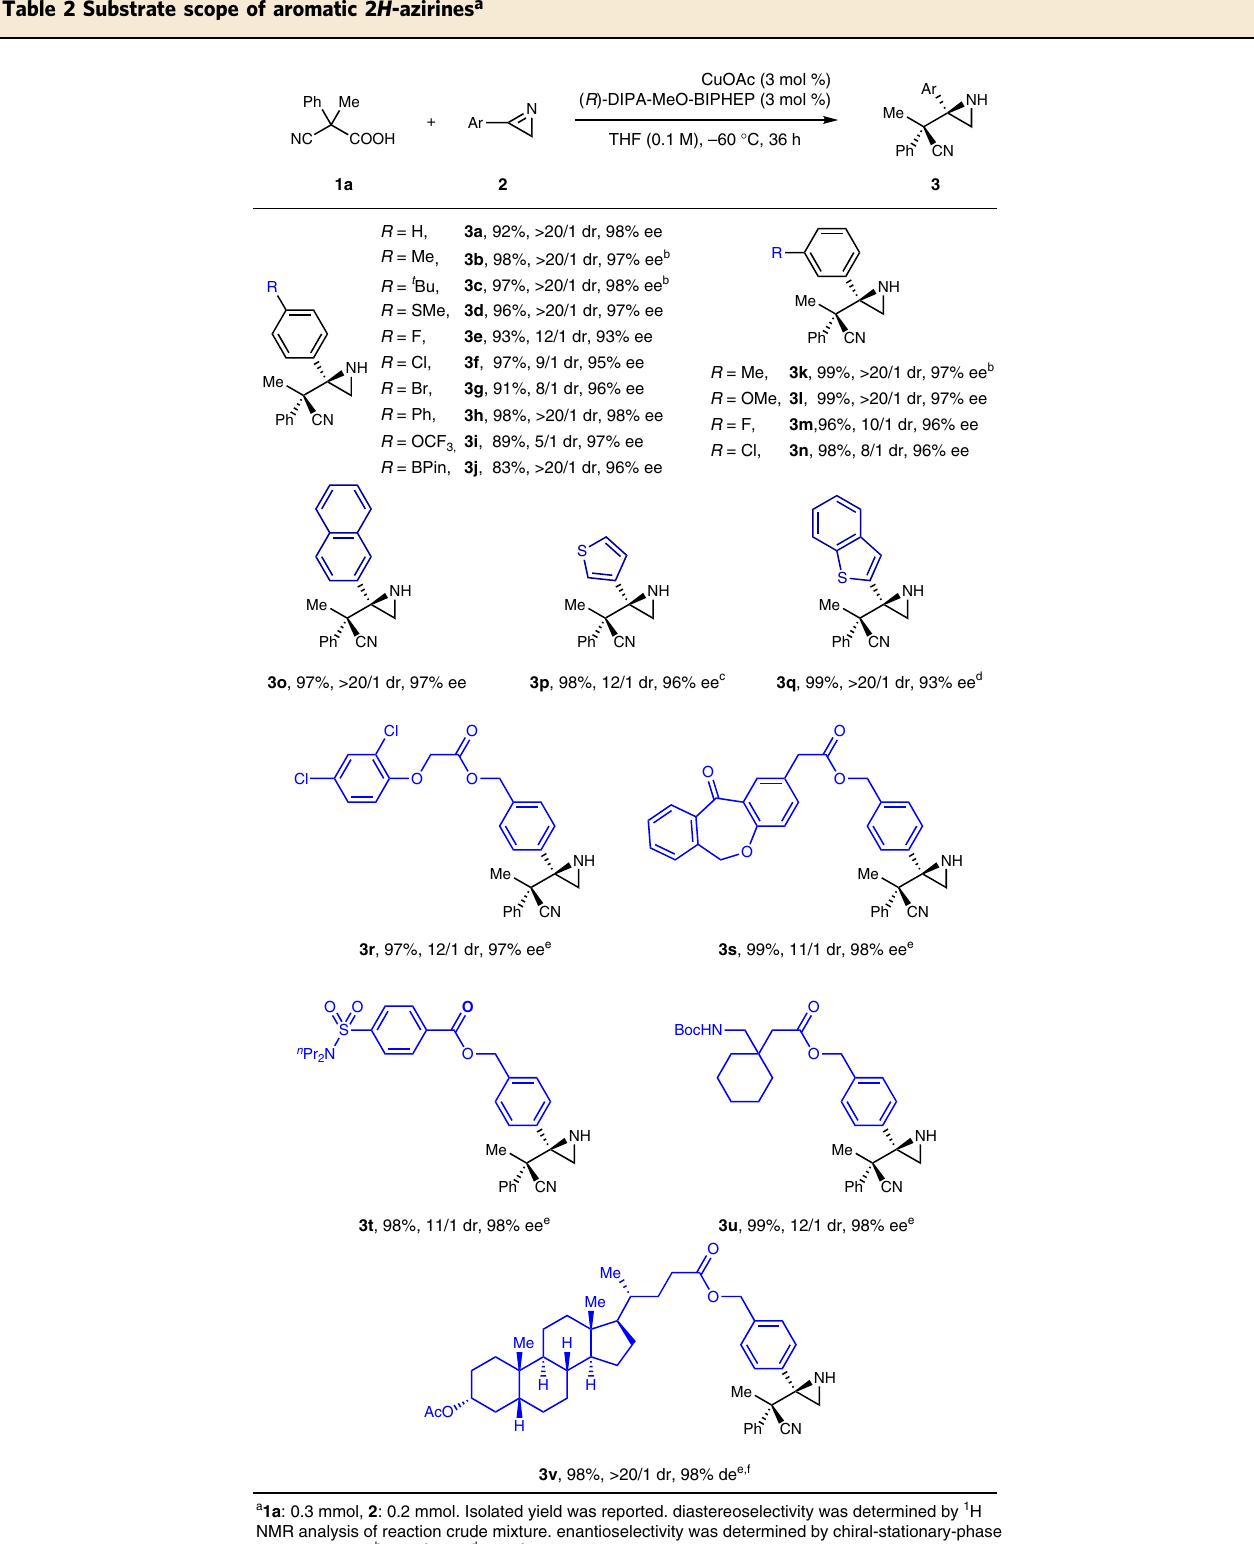
Table 2 Substrate scope of aromatic 2 H -azirines